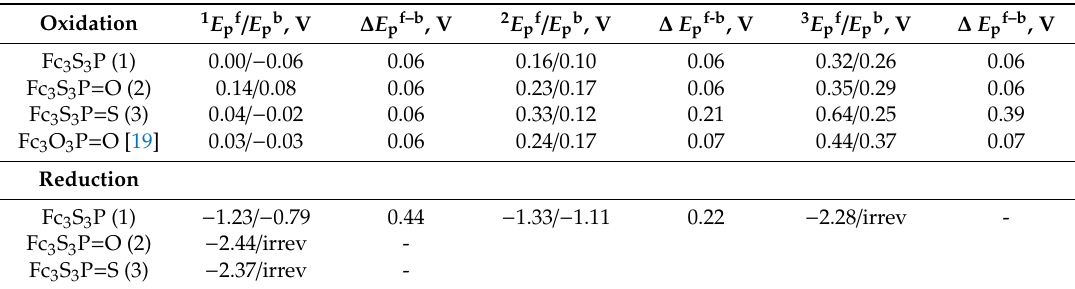
Table 2. Electrochemical data for oxidation-reduction of 1–3 . Conditions: 0.5 mM, CH 3 CN, 0.1 M